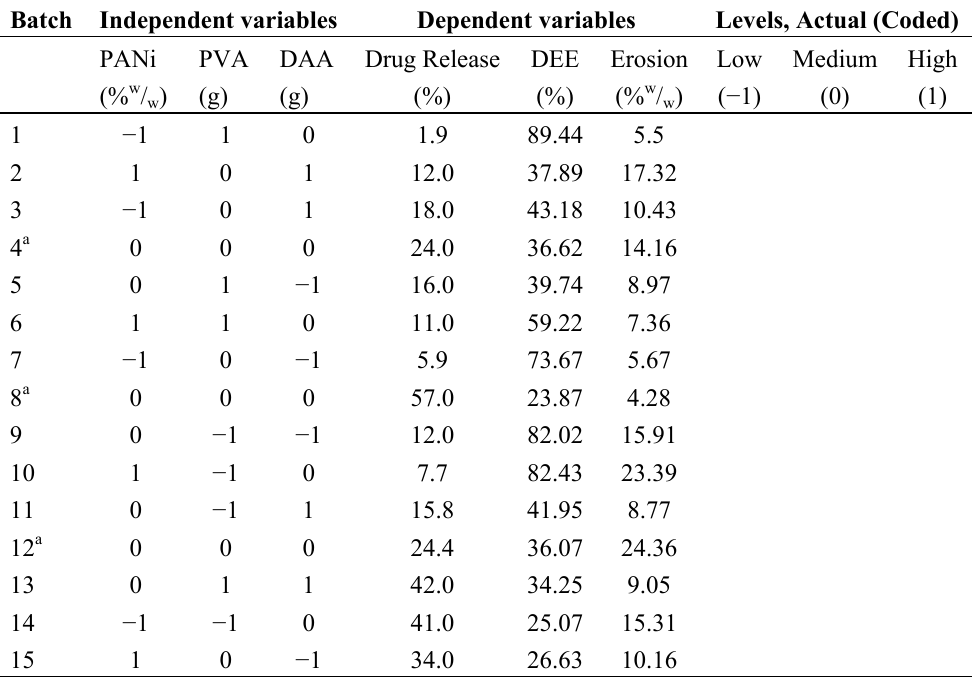
Table 1. Box-Behnken guided variables and observed responses for the ECH formulations. Batch Independent